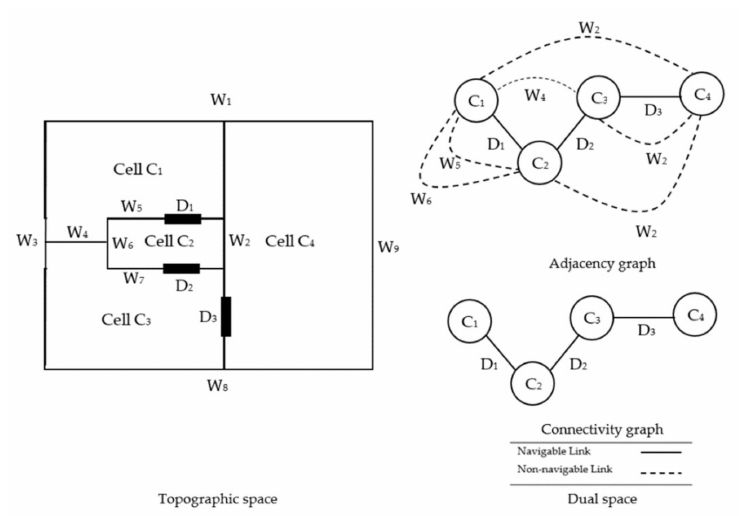
Figure 4. Extracting adjacency and connectivity graph from two-dimensional topologic indoor space.